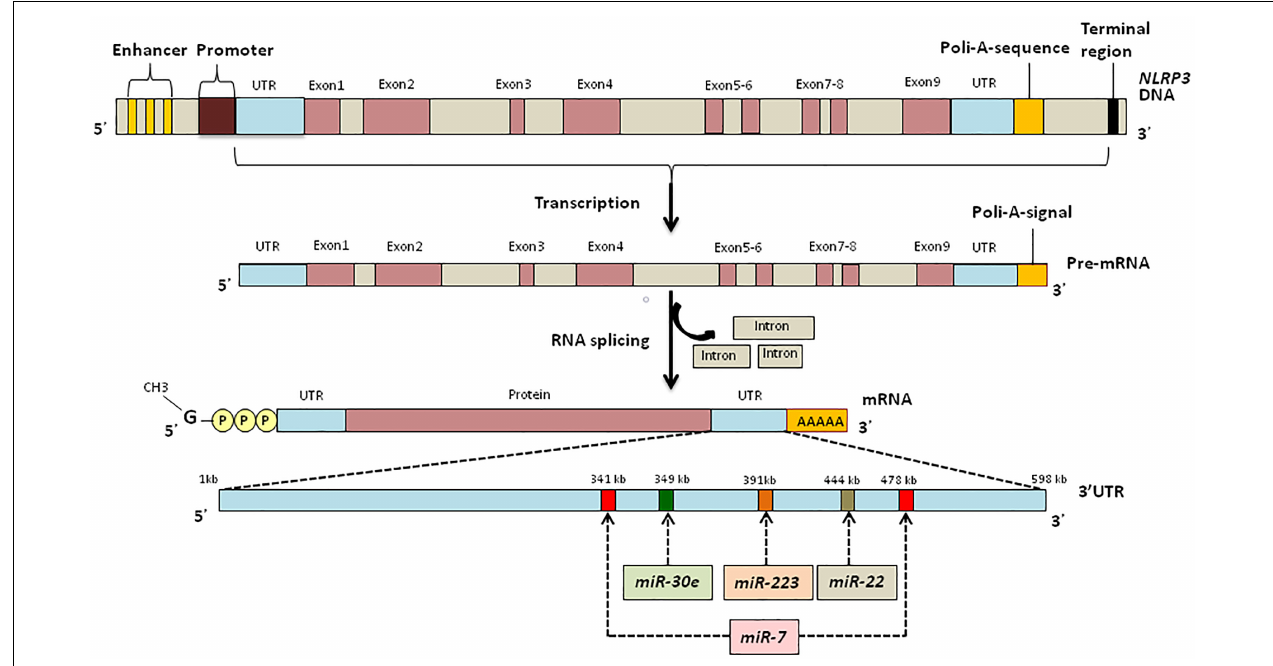
FIGURE 3 | UTR binding sites of NLRP3 for miRNAs responsible for the regulation of